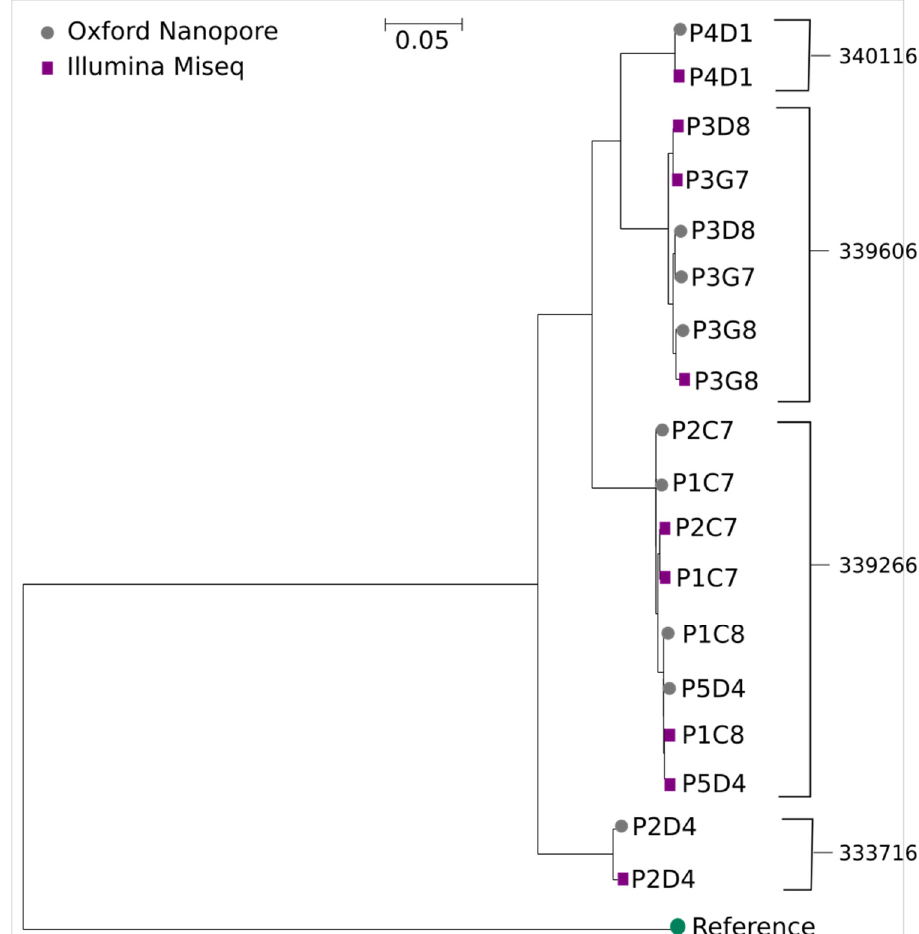
Figure 2. A neighbour-joining phylogenetic tree (generated using Dnapars from the PHYLIP pack-